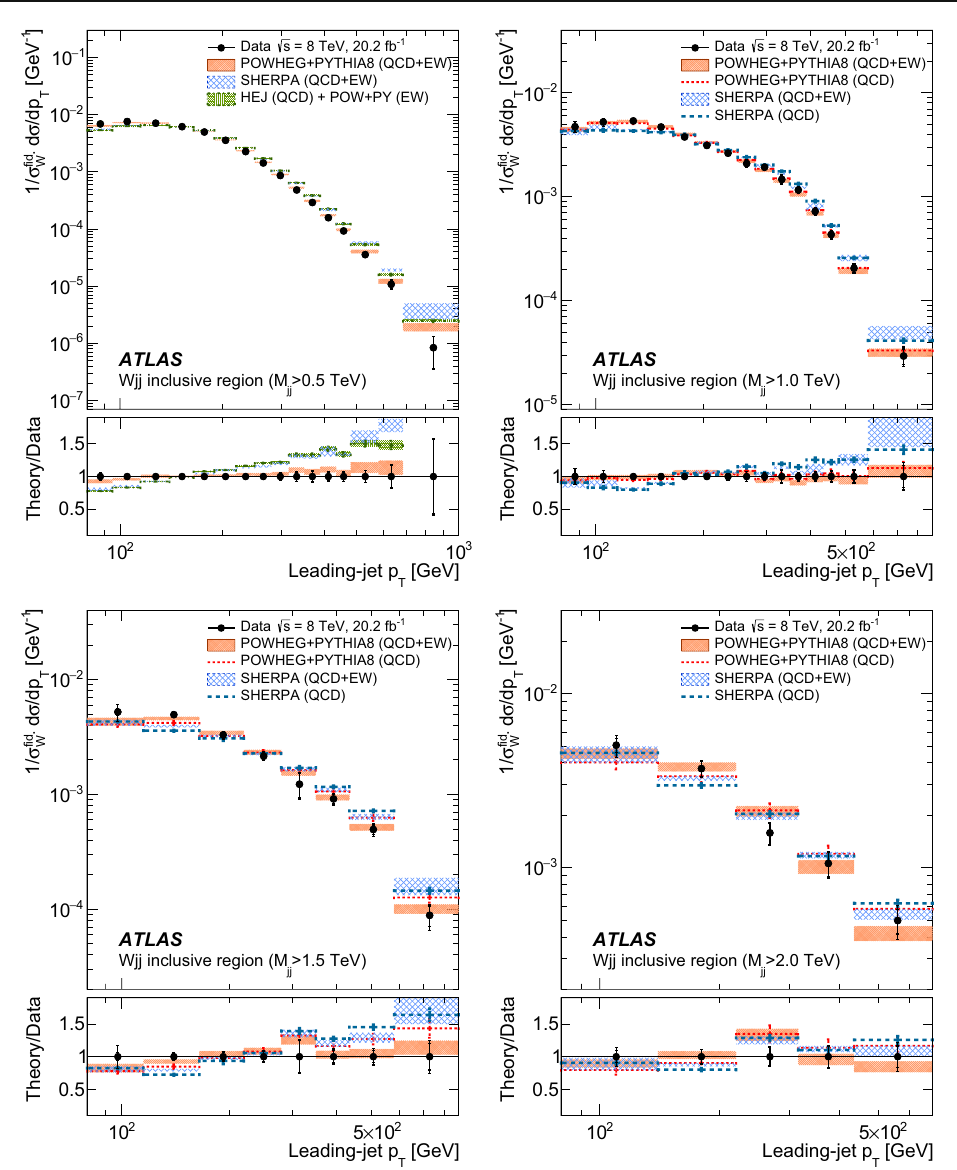
Fig. 41 Unfolded normalized differential W jj production cross sec- tions as a function of the leading-jet p T in the inclusive fiducial region with four thresholds on the dijet invariant mass (0.5, 1.0, 1.5, and